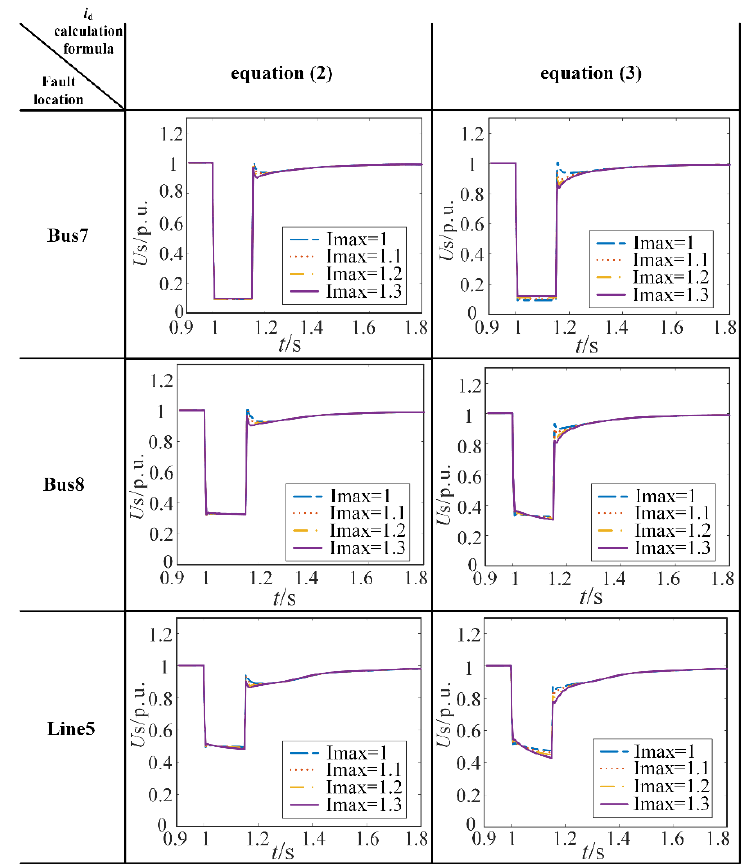
Figure 6. PV parallel node voltage in each simulation scenario.